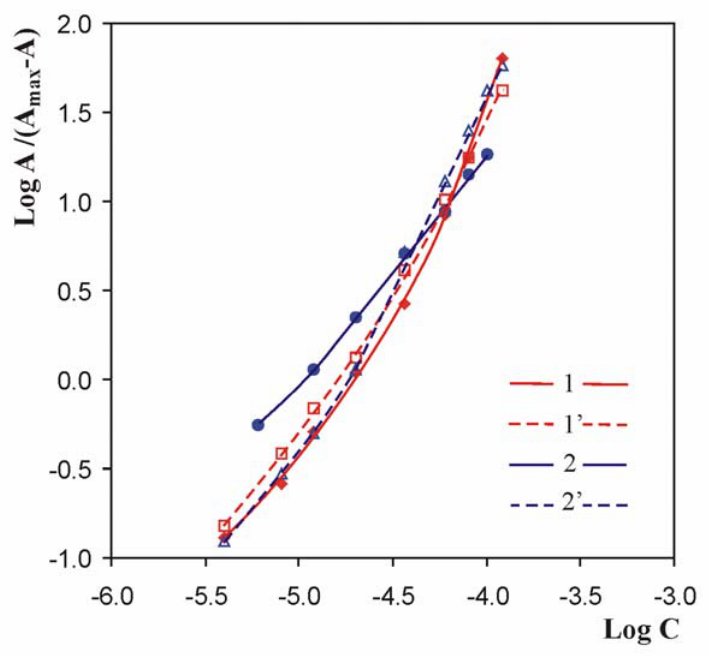
Fig. 4 Determination of the V(V) to INT (curve 1), TAR (curves 1’ and 2’) and NBT (curve 3) ratios according to the equilibrium shift method: 1 - C C =2x10 − 4 mol l − 1 , pH=4.75; 1’ - C =2x10 − 5 mol l − 1 , C TAR V ( V ) pH=4.75; 2 - C =2x10 − 5 mol l − 1 , C =2x10 − 4 mol l − 1 , pH=5.5; 2’ - C V ( V ) TAR